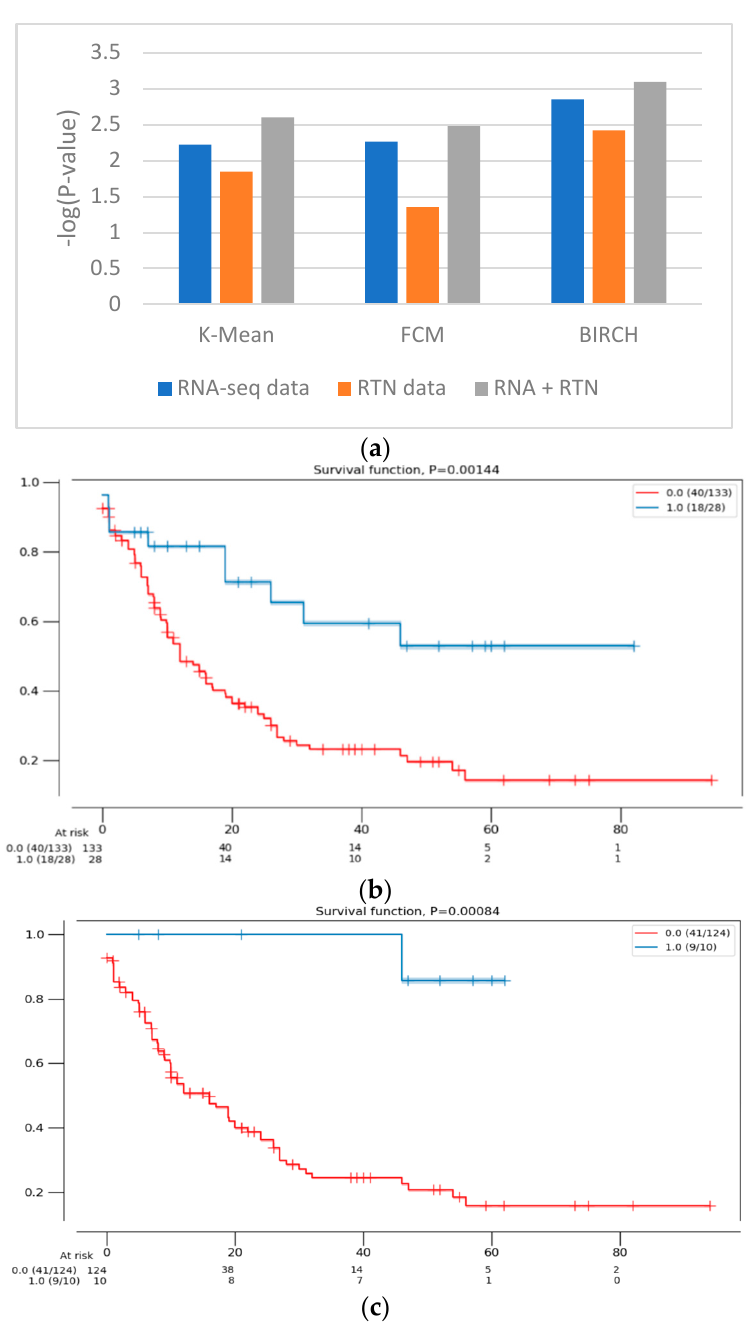
Figure 1. Silhouette Coefficient analysis of different features and clustering methods. Silhouette Coefficient scores were calculated for clusters generated with three methods (as denoted in the graph): K-means, FCM and BIRCH. Briefly, the Silhouette Coefficient reflects the ratio between the average geometric distance between patients in the different clusters to patients in the same cluster. Silhoue tt e Coe ffi cient values range from − 1 to 1, with a value of 1 re fl ecting perfect separation between clusters. Each of the clustering methods was applied to three datasets, differing only in the features they involve: the first included only RNA-seq data (blue); the second included only RTN-derived features (Orange); and the third included both kinds of features (gray).